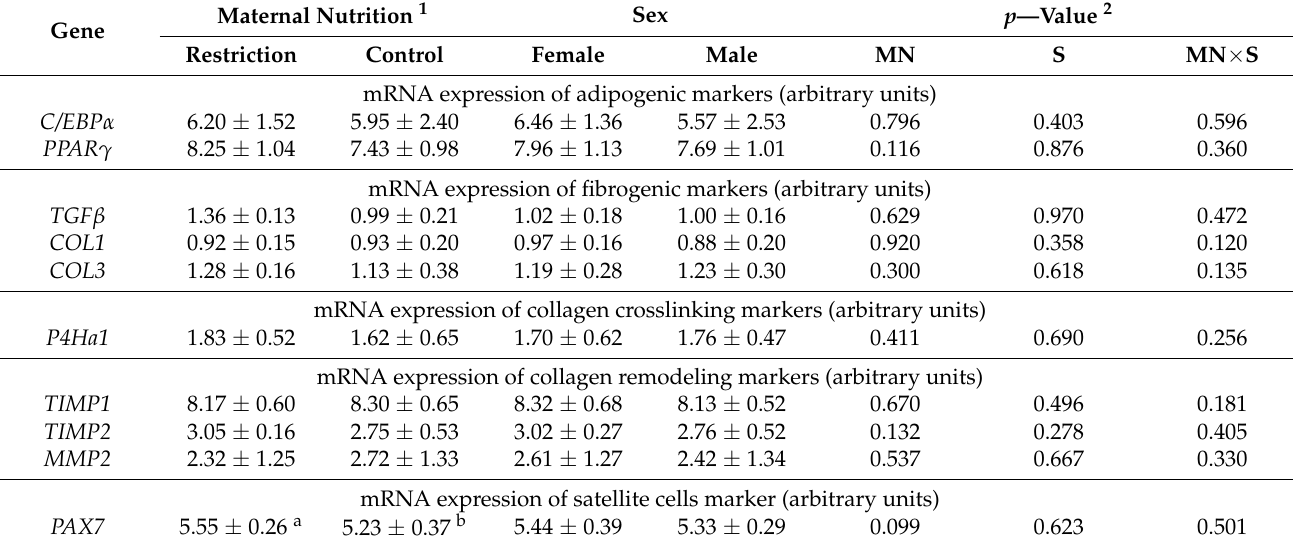
Figure 2. Interaction effect between maternal treatment (CON vs. RES) and offspring’s sex (FEMALE vs. MALE) on the relative gene expression of Zfp423 ( A ), FN ( B ), LOX ( C ), PDGFR α ( D ), and MHC1 ( E ) at 30d. Different letters indicate differences among groups. Tendency was considered when 0.10 < p > 0.05 and significant differences when p < 0.05. Table 3. Least square means ± standard errors for mRNA expression of adipogenic, fibrogenic, collagen crosslinking, collagen remodeling, and satellite cells markers evaluated on the skeletal muscle of the 30d offspring according to maternal nutrition and